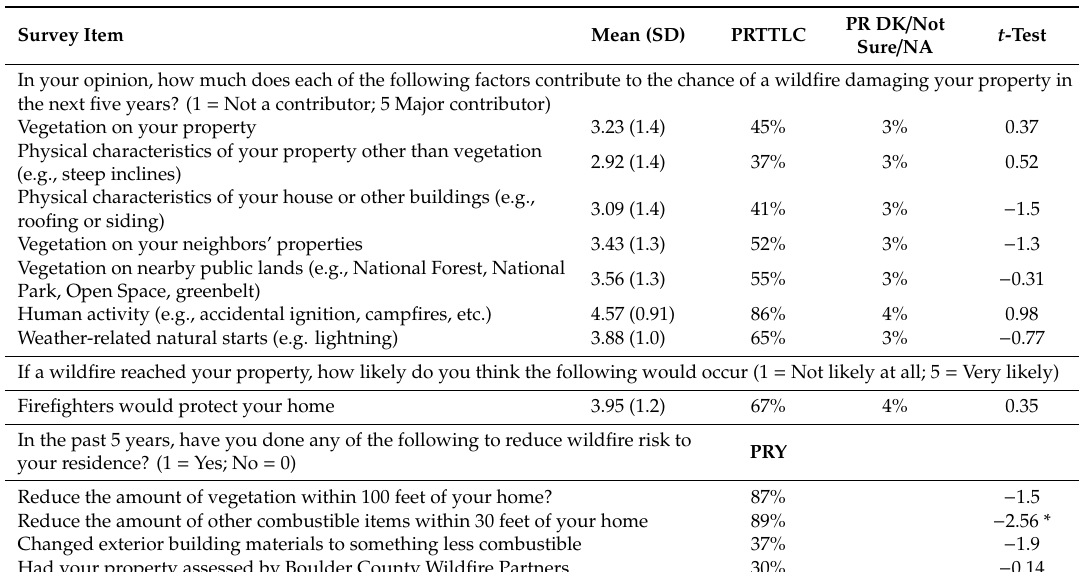
Table 6. Wildfire